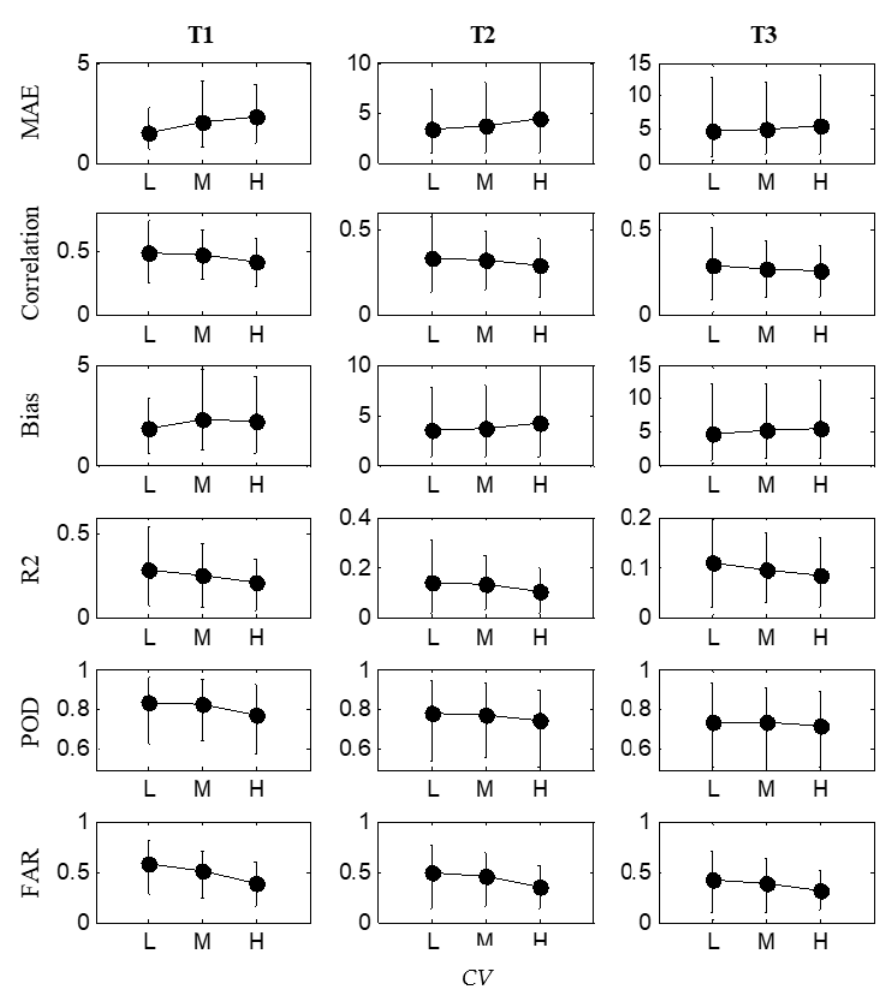
Figure 8. Relationship between rainfall nowcasting skill and rainfall temporal CVs.